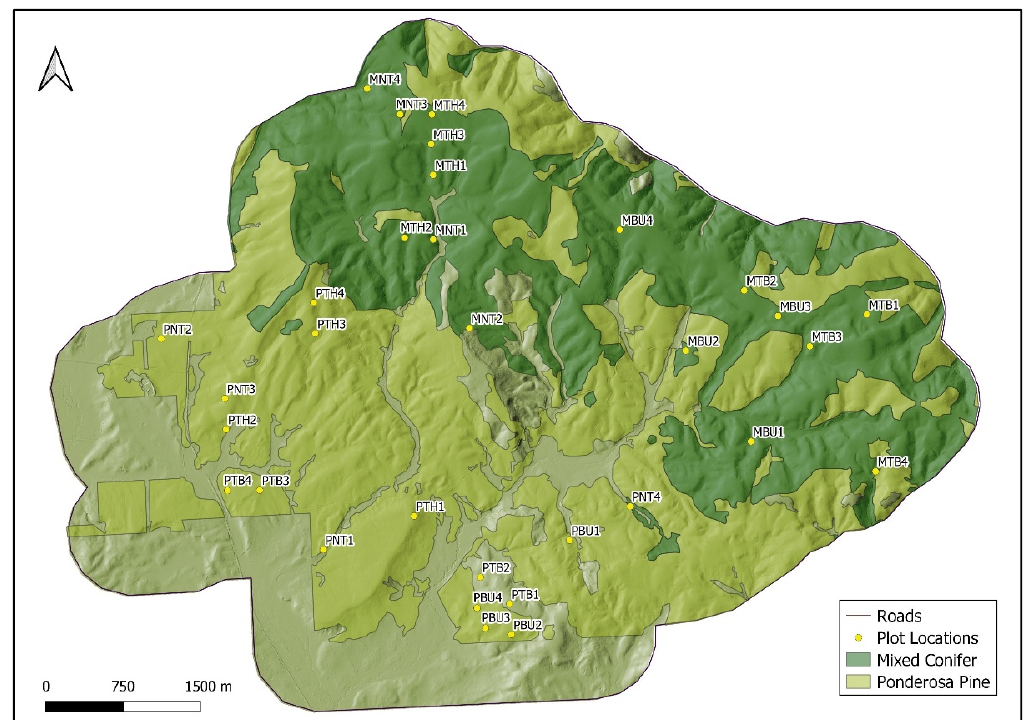
Figure 2. The study area stratified by forest type (ponderosa pine and mixed conifer) with plot locations; Malheur National Forest near John Day, OR, USA.